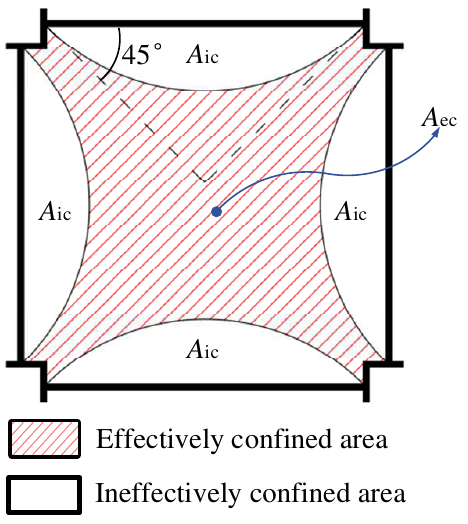
Figure 16. Division of effectively and ineffectively areas.